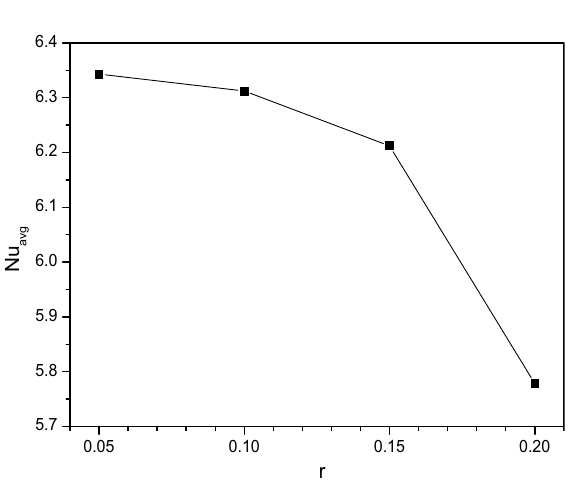
Figure 23. Variations of the streamlines ( (cid:31) ) and isotherms ( T ) with r at Ra = 10 6 , Ha = 0 , Da = 0.01 , ε = 0.2 and φ = 0.02 .